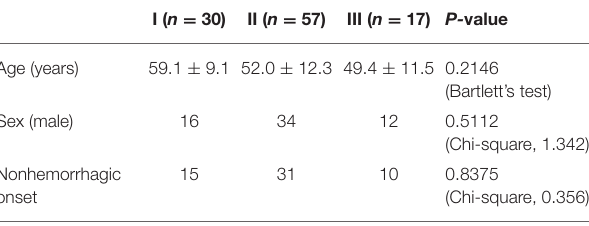
TABLE 4 | Baseline data of type I, II, and III EVTs.